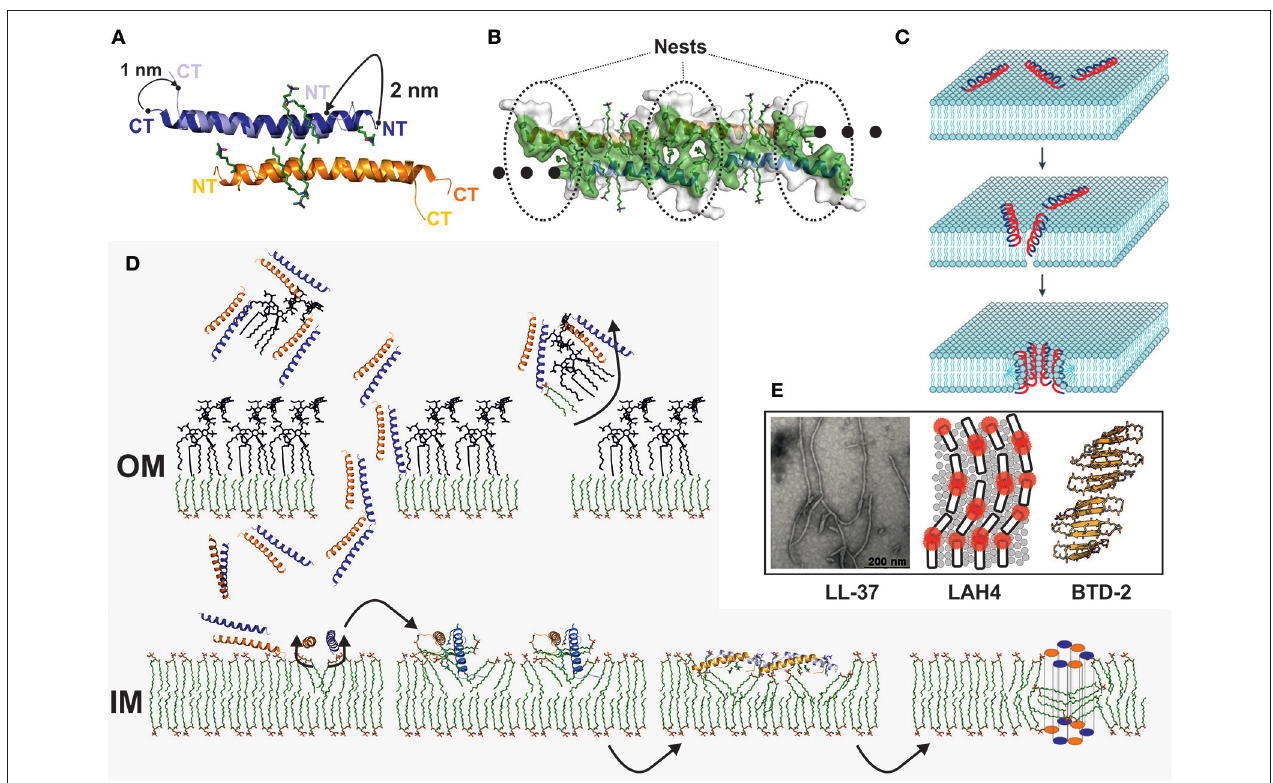
FIGURE 2 | Structure and membrane interaction mechanism of human cathelicidin. (A) Structure comparison of the LL-37 dimer in the presence and absence of detergents. Detergents induce a significant conformational change at the N- and C-terminus and discrete detergent binding sites are formed. (B) LL-37 tetramer in a surface representation. Hydrophobic residues on the side are marked in green. At the interface between two dimers, nest-like hydrophobic structures are formed to accommodate detergents in vitro . Lipid molecules in vivo may occupy these detergent positions, and lipid molecules or detergents may initiate the oligomerization of the channel. (C) Simplified mechanism describing the toroidal model which explain the activity of AMPs which are in a first step electrostatically attracted by membranes followed by their assembly and partial integration. In a final step the peptides form channels based on peptide-peptide and peptide-lipid interactions after full integration into lipid bilayers (Brogden, 2005). This figure is reprinted with permission from by Brogden (2005). (D) Model for the interaction of LL-37 with the cell wall of a Gram-negative bacterium. Significant interactions between LL-37 and LPS have been demonstrated, and, as a hypothesis, LPS may be translocated apart from the cell wall in order to build holes for the translocation of LL-37 into the periplasmic space (Scientific reports in press; Vandamme et al., 2012). Interactions of the peptide with lipid molecules will initiate the conformational changes, and fiber-like oligomers may form on the inner membrane. These fibers lead to an increased local concentration of the peptide and will interfere with the membrane stability. (E) Related models and experimental data which were recently published in the literature are based on fluorescence techniques applied to LAH4, crystallography and analysis of crystal packing of BTD-2 and electron microscopy of LL-37 mixed with lipid vesicles (Aisenbrey and Bechinger, 2014; Shahmiri et al., 2016; Wang et al., 2016). LL-37 TEM figure is reprinted from Shahmiri et al. (2016) published in open-access under CC BY 4.0 license. LAH4 figure is reprinted with permission from by Aisenbrey and Bechinger (2014). Copyright 2014 American Chemical Society. BTD-2 figure is reprinted with permission from Wang et al. (2016). Copyright 2016 American Chemical